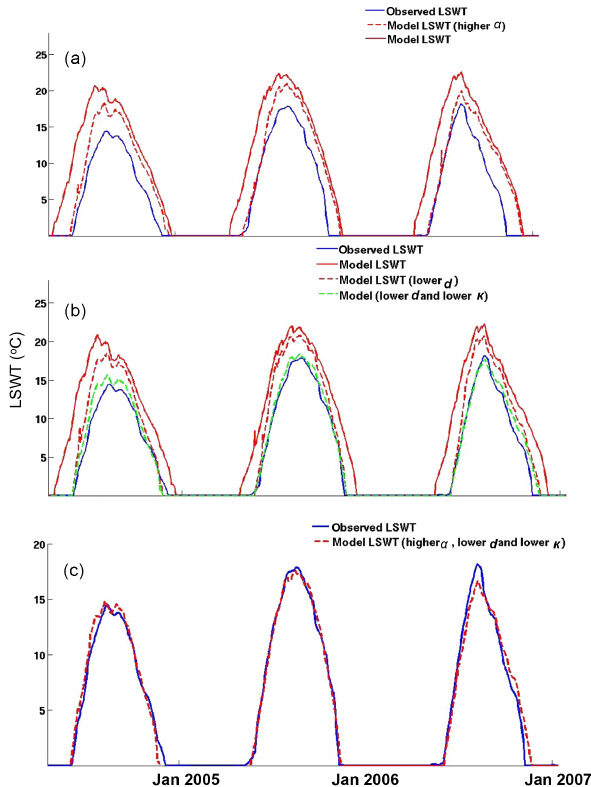
Figure 1. Preliminary modelled runs for Lake Athabasca, Canada (59 ◦ N 110 ◦ W), showing that adjustments to lake depth ( d) , snow and ice albedo ( α) and light extinction coefficient ( κ) can greatly improve the modelled lake surface water temperatures (LSWTs) compared to the default/recommended d , α and κ values; (a) shows that a higher α causes a later ice-off date, comparing well with the observed (ARC-Lake) ice-off date, (b) shows that a lower d causes an earlier ice-on date and a lower κ value (greater transparency) re- duces the maximum LSWT and (c) shows that the combined effect of the adjusted d , α and κ produce LSWTs that are highly compa- rable to the observed ARC-Lake LSWTs.